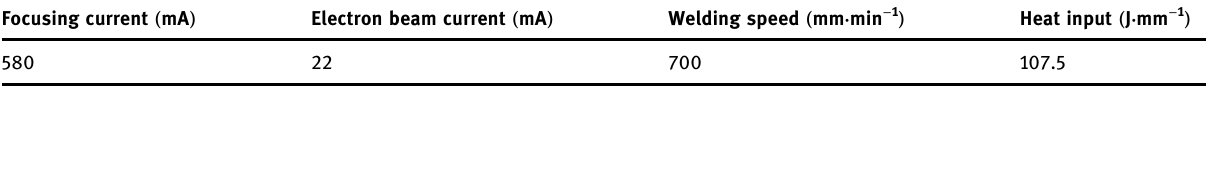
Table 2: P - LBW parameters of TA15 titanium alloy Pulse duration ( s